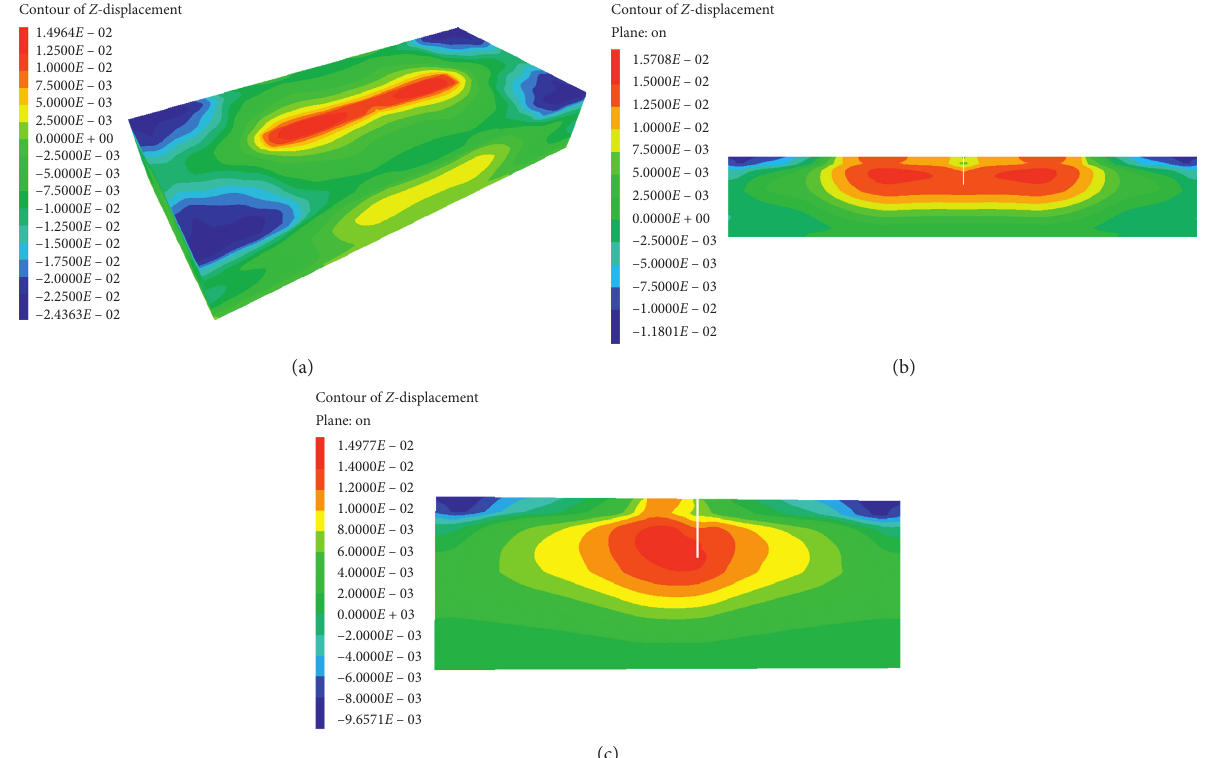
Figure 20: Single well subsidence nephogram after the third drawdown (unit: m). (a) Three-dimensional diagram. (b) Cross section of the well midpoint. (c) Longitudinal section of the well midpoint.